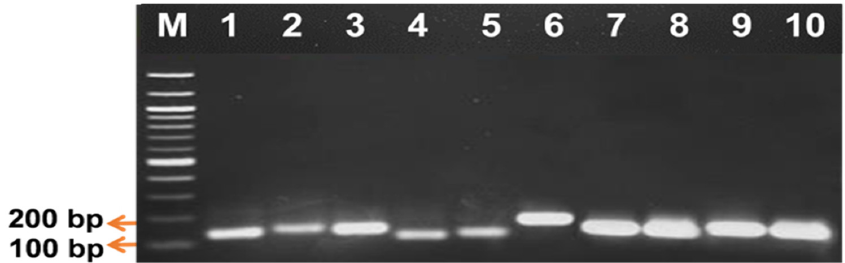
Figure 3. PCR amplification of oil palm root samples analyzed on 1.5% ( w / v ) agarose gel electropho-